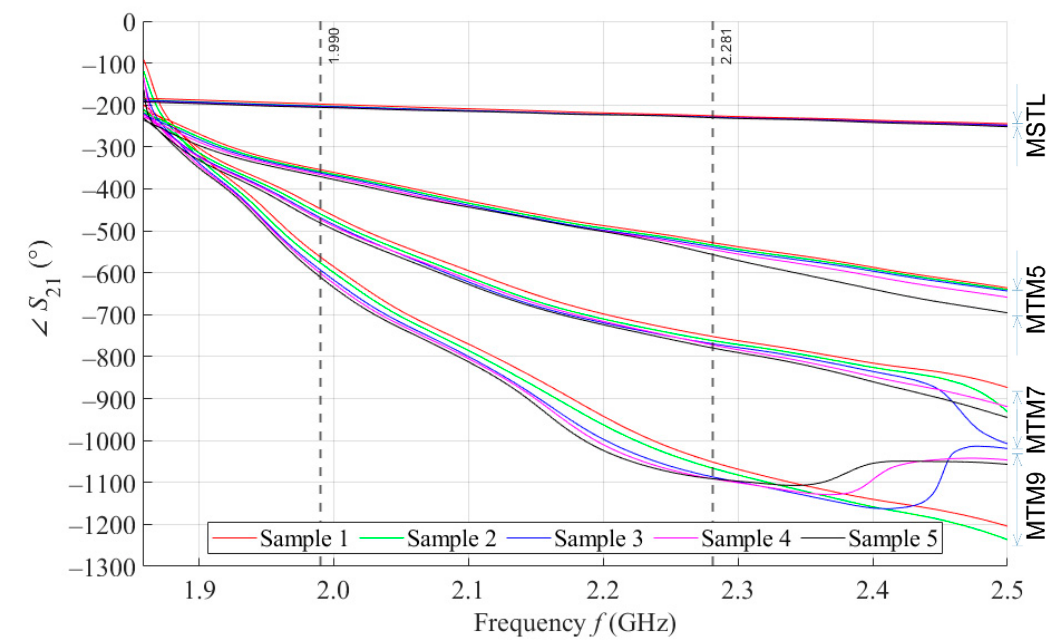
Figure 6. The course of ∠ S 21 for all tested sensors.